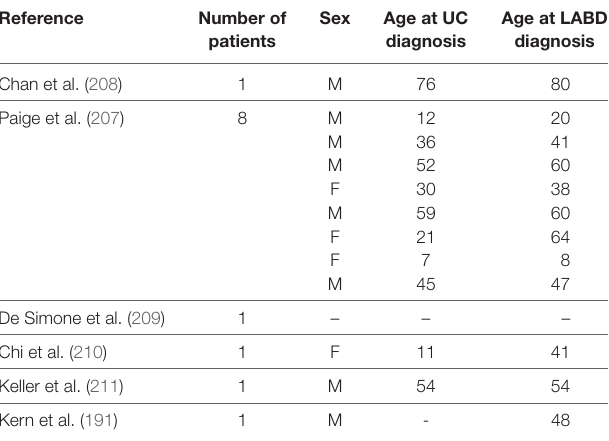
TABLe 5 | LABD patients with